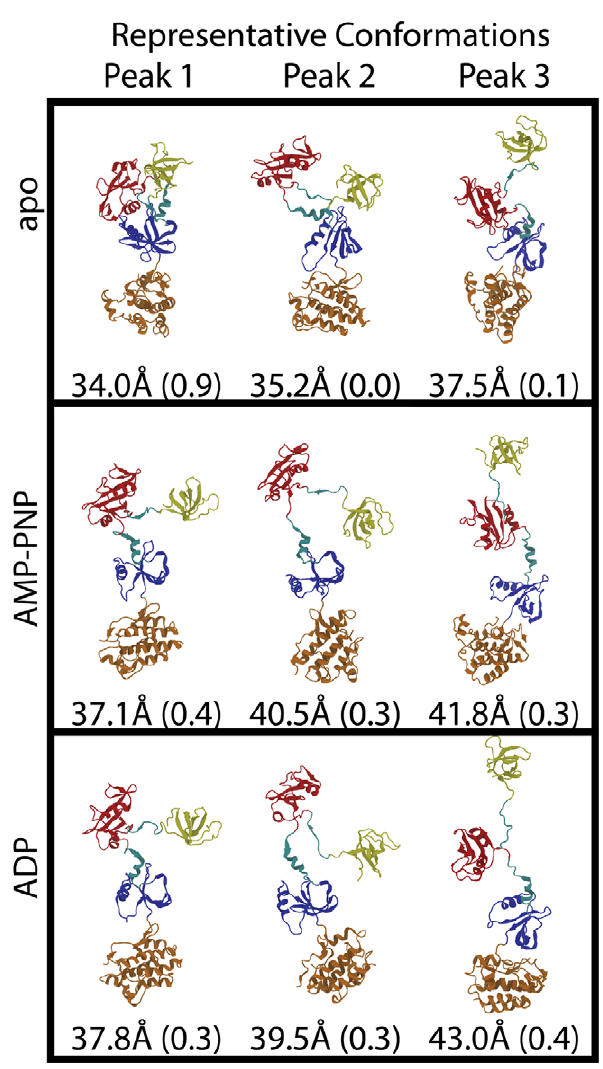
Figure 3. Representative conformations from the peaks of the P(R g ) plot, along with their R g values. Appearing next to the R g values of each conformation is the fraction of the best-fit ensemble made up by that conformation. For all conformations the SH3 domain appears in yellow, the SH2 domain appears in red, the N-lobe of the kinase domain appears in blue, the C-lobe of the kinase domain appears in orange, and the domain-domain linkers appear in